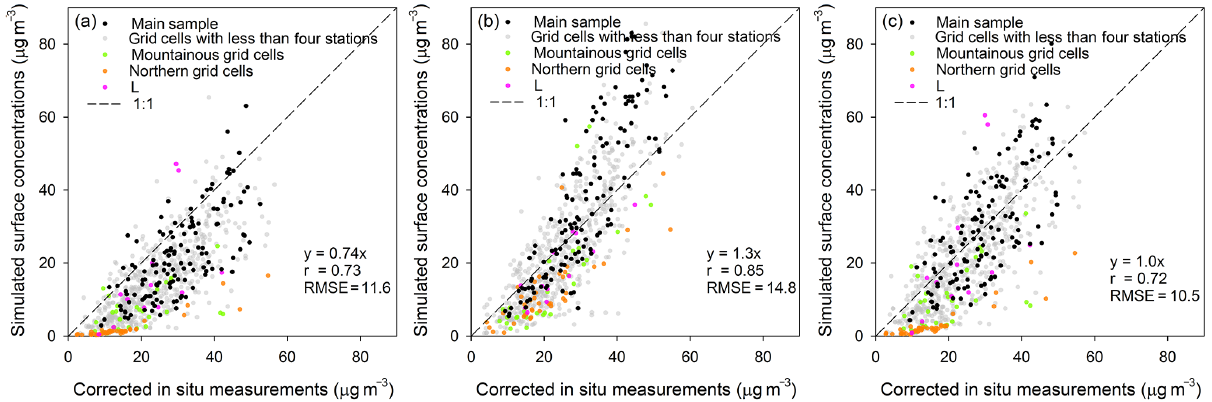
Figure 7. Scatter plots of the simulated annual mean surface NO 2 concentrations in 2015 driven by (a) the DECSO inventory, 2015; (b) the MIX Asian inventory, 2010; and (c) the corrected DECSO inventory and the corrected in situ measurements. The orange dots correspond to the grid cells with a latitude higher than 45 ◦ N. The pink dots correspond to the grid cells labeled with “L” in Fig. 6. The corrected DECSO inventory is derived by scaling the total amount of NO x emissions from the DECSO inventory to that from the MIX inventory. The intercept is set to 0 when performing the regression.